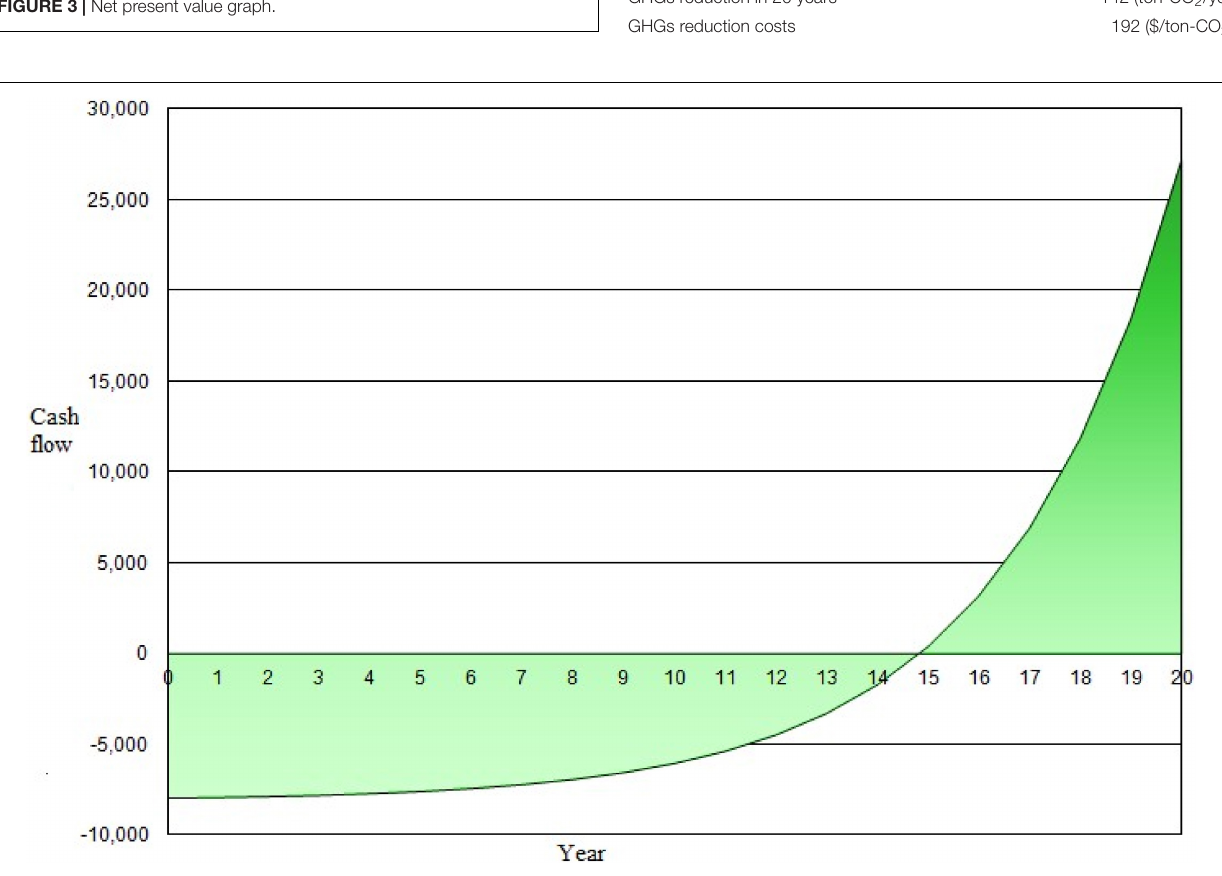
FIGURE 3 | Net present value graph.